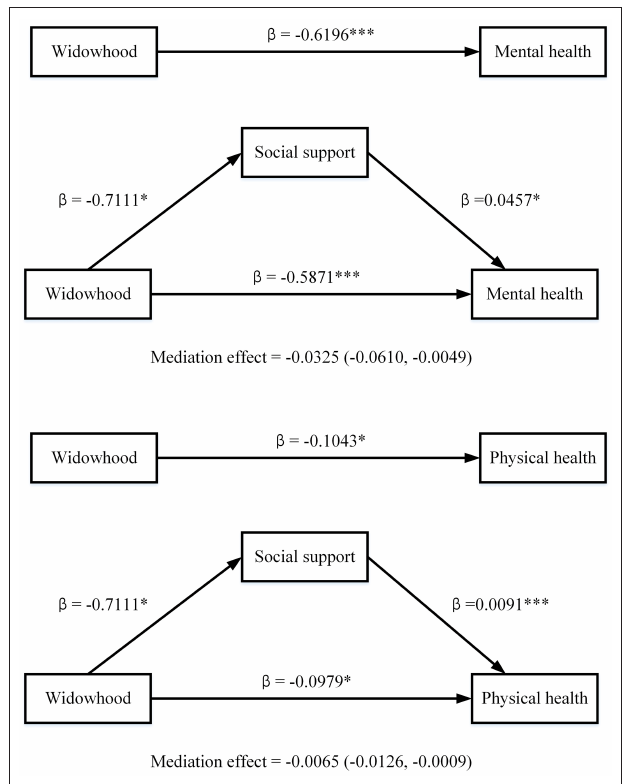
FIGURE 1 | Mediating effects of social support in the association between widowhood and health ( N = 7,647). Adjusting for gender, age, ethnicity, hukou, education, religion, social participation, and living arrangement; * p < 0.05, *** p < 0.001; Confidence intervals do not cross zero means the relationship is